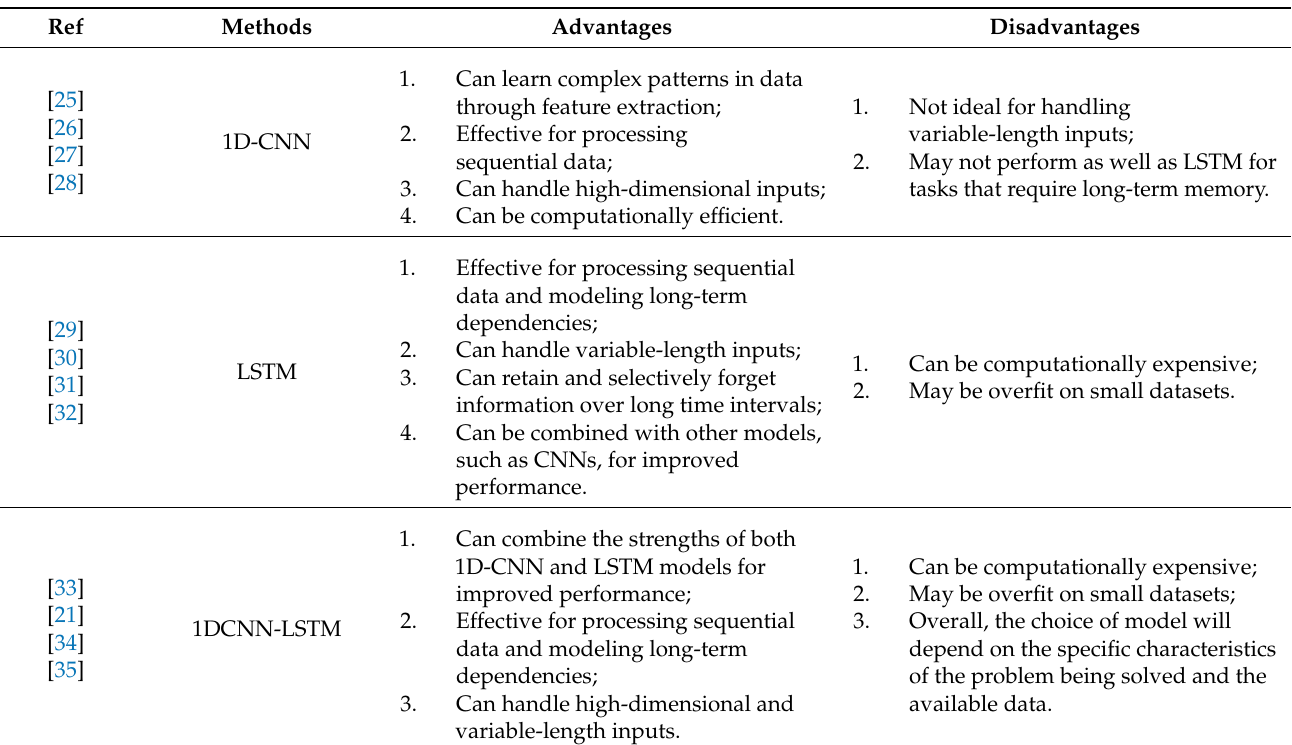
Table 1. Summary of the advantages and disadvantages of the proposed